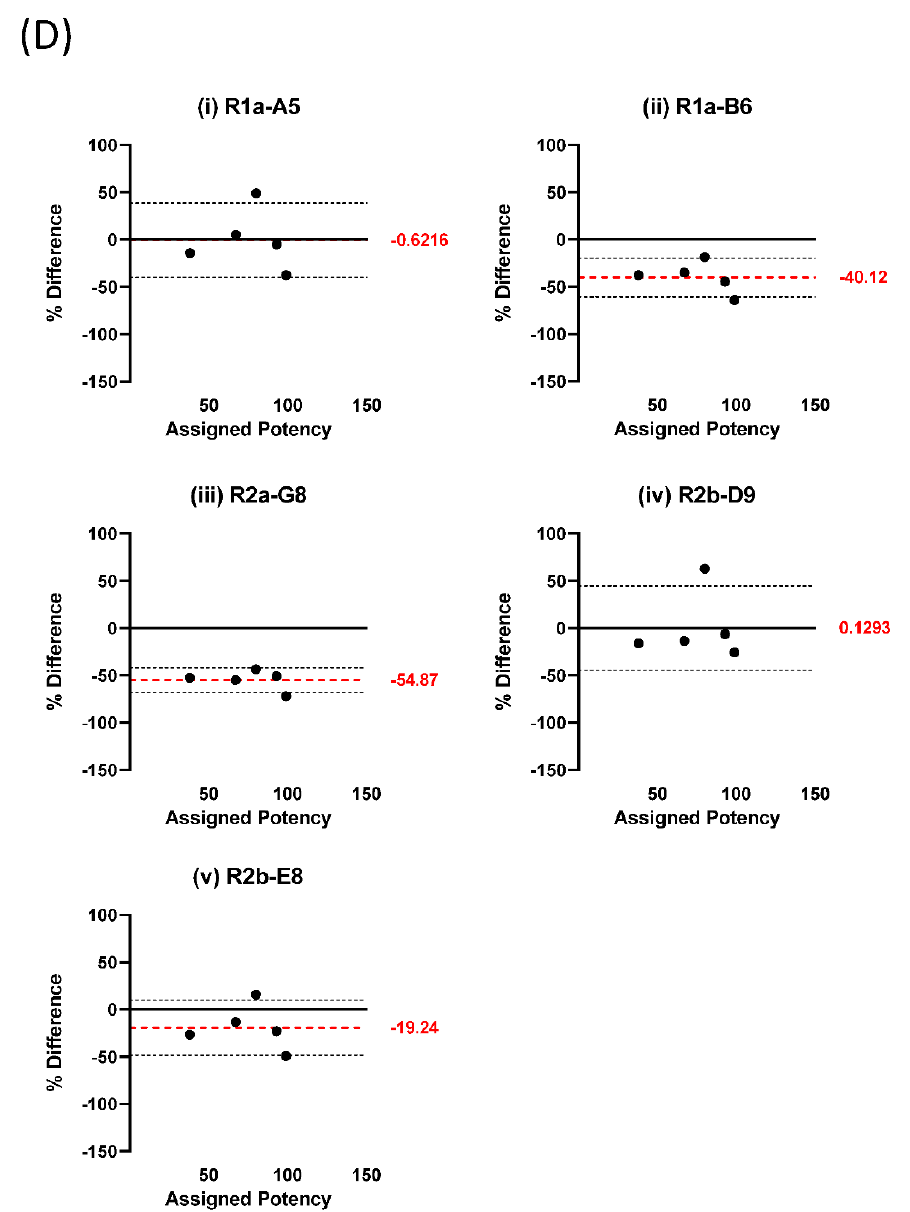
Figure 1. Difference plot analysis of results from competitive ELISA using different nanobodies. The percent differences between assigned values (in μg/mL) and values estimated by competitive ELISA with nanobodies R1a-A5 ( i ), R1a-B6 ( ii ), R2a-G8 ( iii ), R2b-D9 ( iv ) and R2b-E8 ( v ) are shown for ( A ) A(H1N1)pdm09 antigen reagents, ( B ) A(H1N1) antigen reagents from 1976–2007 and ( D ) H5 sub- type antigen reagents. ( C ) A dose–response curve is shown for nanobody R2b-E8 which only reacted with one antigen reagent out of the H1N1 reagents from 1976–2007 in competitive ELISA. Black dotted lines indicate 95% confidence intervals; red dotted lines indicate average percentage differences.